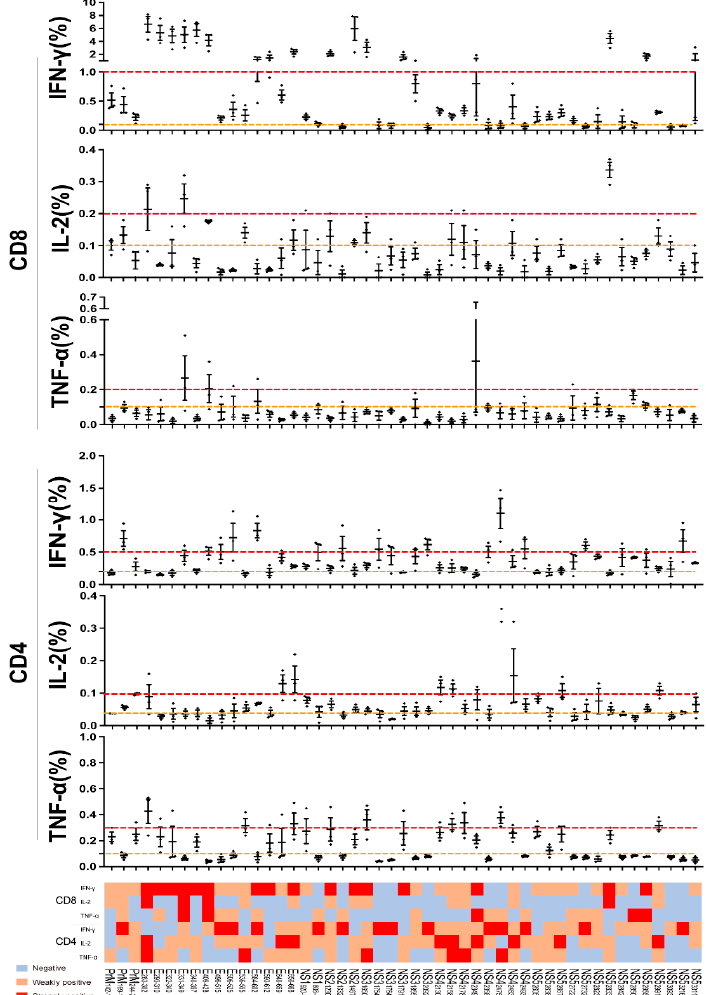
Figure 4. Peptides immunothermogram analysis of CD8+/CD4+ T cell in H-2 b and H-2 d mice. Wild- type C57BL/6 (H-2 b ) mice were infected with 10 4 FFU of ZIKV, splenocytes were harvested at 14 d.p.i. and stimulated with above-positive peptides to assess cytokines production by ICS. The per- centages and heat map analysis of IFN- γ , TNF- α and IL-2 produced in CD8+ / CD4+T cells in H-2 b and H-2 d mice ( n = 3 per peptide). Dashed lines between red and yellow are weakly positive, beyond red are strongly positive.